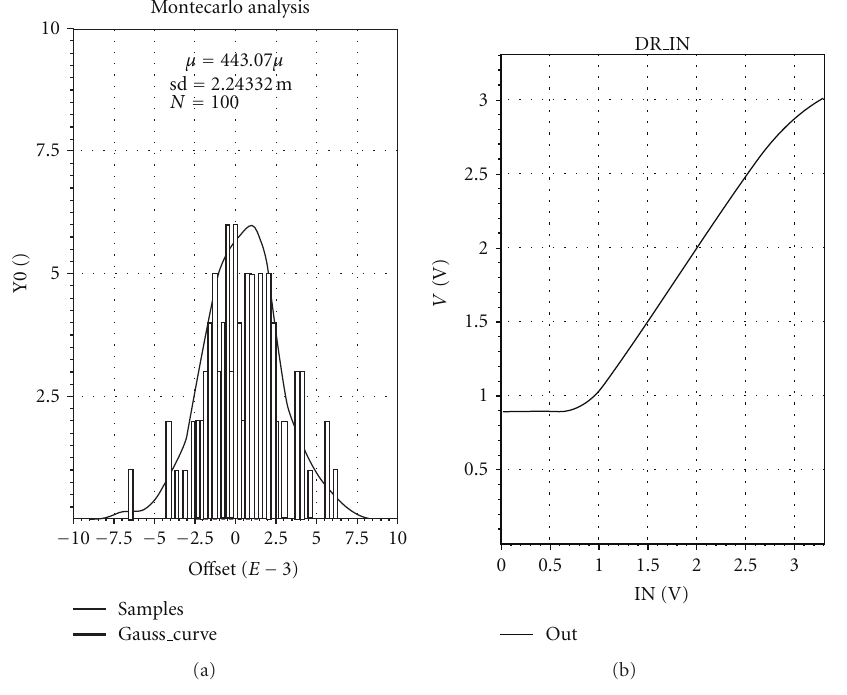
Figure 16: OTA o ff set and input DR simulations.